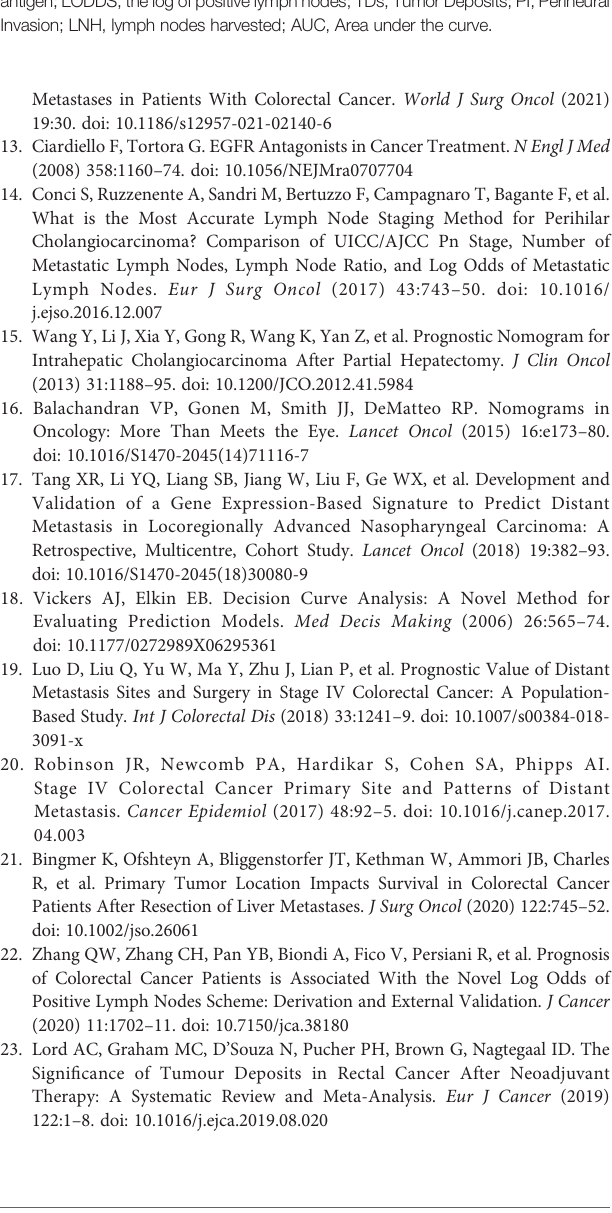
Supplementary Table 1 | Exclusion criteria and reasons that we excluded patients. Abbreviations: CEA,carcinoembryonic antigen;LODDS, the logofpositive lymph nodes; AJCC, American Joint Cancer Committee. Supplementary Table 2 | Comparison of nomograms related to predicting colorectal cancer metastasis by using SEER. Abbreviations: CEA,